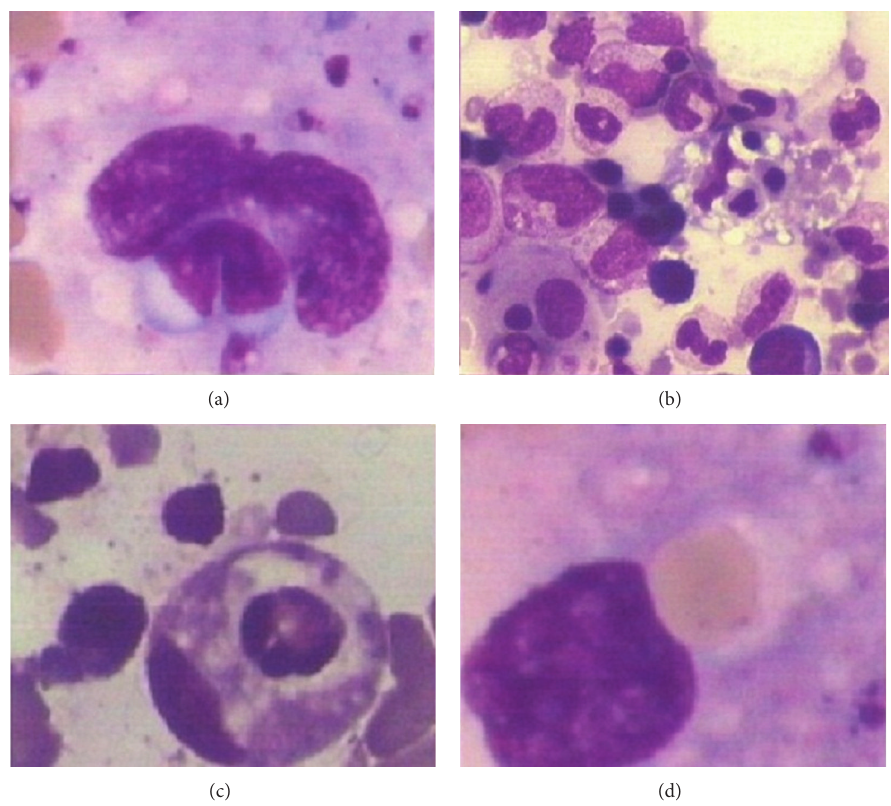
Figure 1: Bone marrow aspirate cytology showing hemophagocytosis in cases of leishmaniasis (Jenner Giemsa; × 400, ×